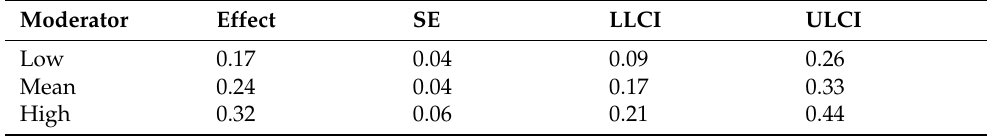
Table 5. Conditional indirect effect at specific values of green organizational identity.